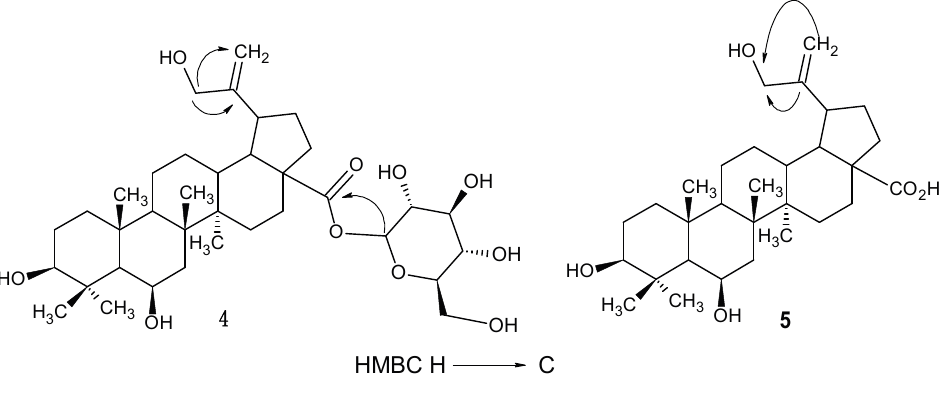
Figure 2. Key HMBC correlations observed for compounds 4 and 5